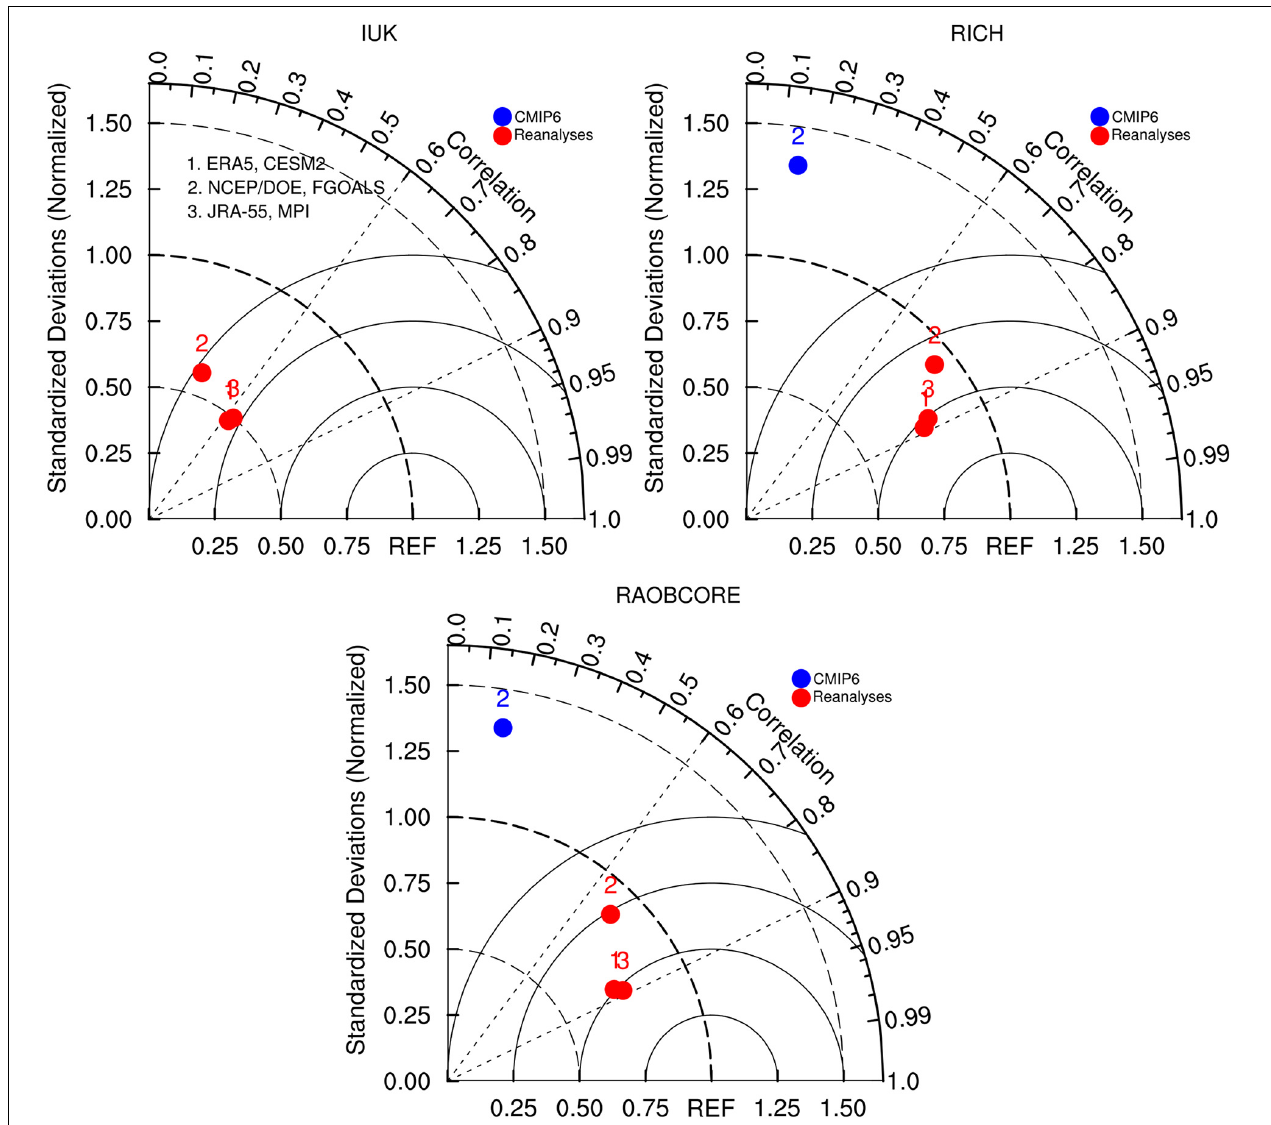
FIGURE 2 | Taylor plot of the reanalysis data and model results with radiosonde